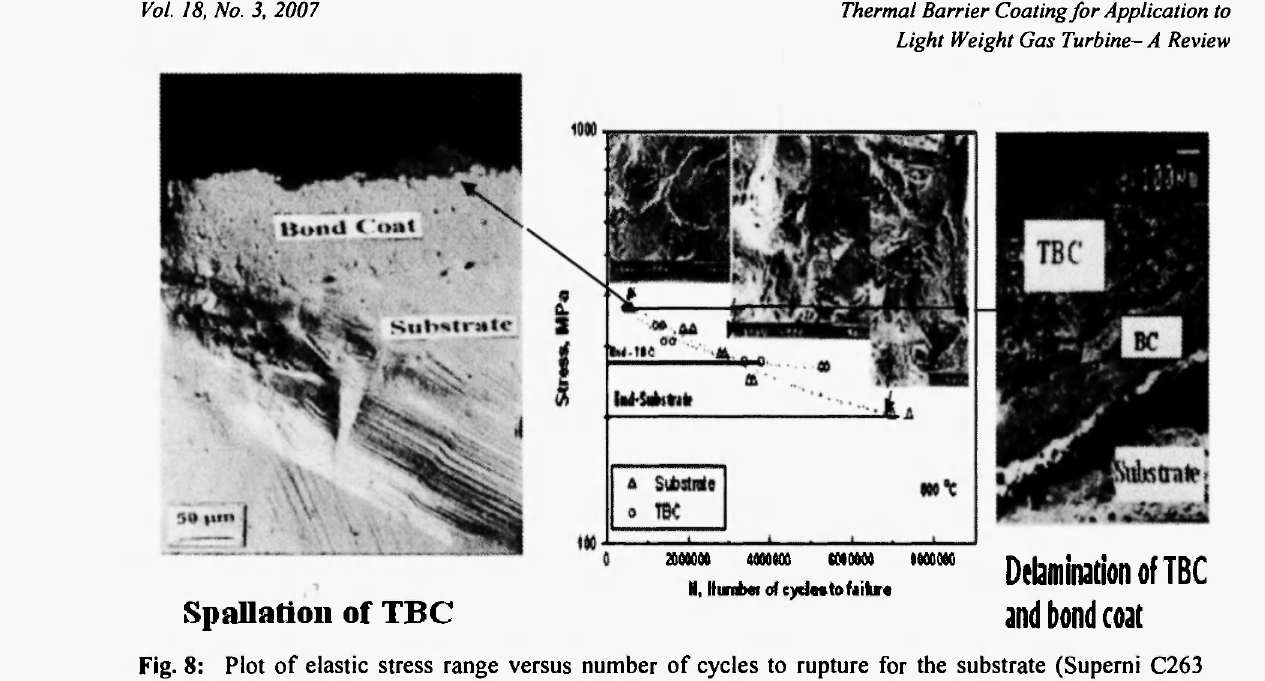
Fig. 8: Plot of elastic stress range versus number of cycles to rupture for the substrate (Superni C263 alloy) and TBC at 800°C /59/. SEM fractograph of a ruptured specimen (on the left) which failed at 90% YS ( 370 MPa) in force- controlled high temperature fatigue tests, revealing spallation of the TBC layer.